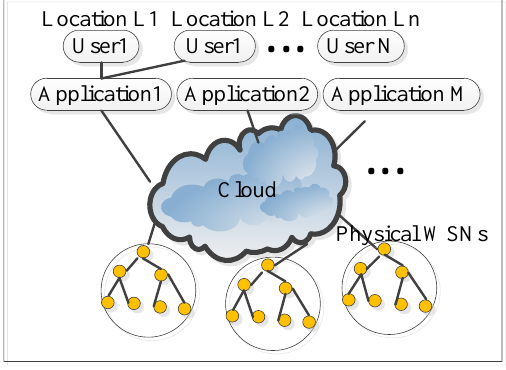
Figure 23. Location-based IoT and cloud interaction.